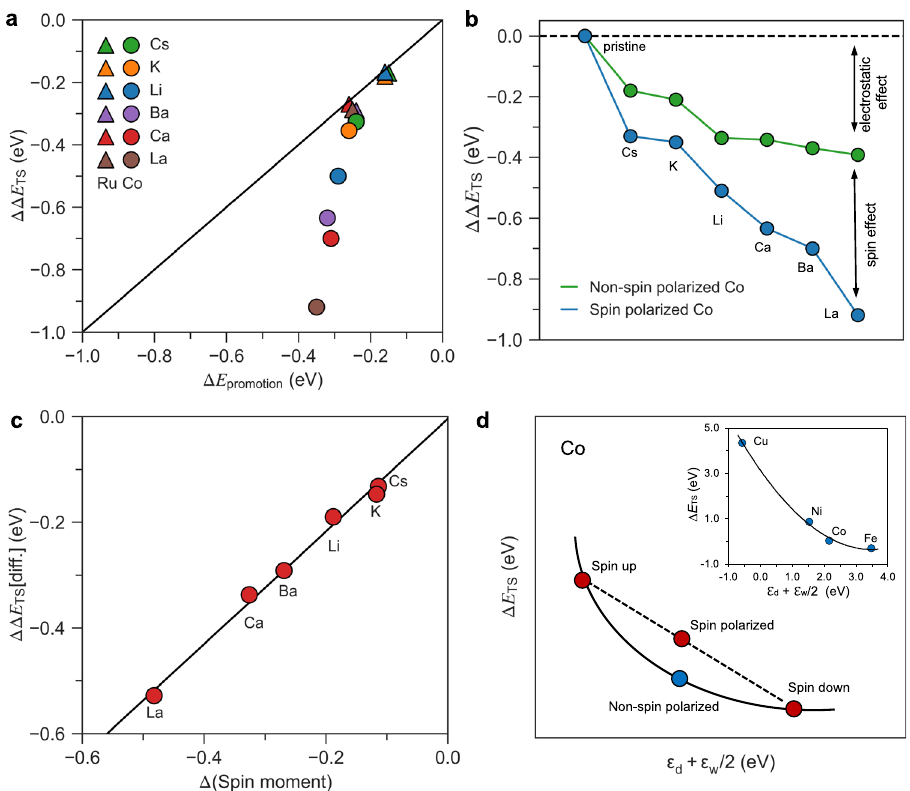
Fig. 3 Electrostatic and magnetic effects. a The N-N transition state (TS) energy stabilization ( ΔΔ E TS = Δ E TS (with promoter) – Δ E TS (without promoter)) for different promoters as a function of the electrostatic promotion ( Δ E promotion = – μ N-N ℇ promoter ). Triangles and squares refer to the Ru and Co surface, respectively. b ΔΔ E TS for different promoters for spin-polarized and non-spin-polarized Co. c The difference ΔΔ E TS [diff] = ΔΔ E TS (spin polarized) – ΔΔ E TS (non-spin polarized) between the TS energy for spin-polarized (blue in b ) and non-spin-polarized (green in b ) Co plotted as a function of the promoter- induced change in spin moment of the Co atoms at the active site (Supplementary Table 9). d Schematic plot of the relation between Δ E TS and the top of the d band on a spin-polarized and non-spin-polarized surface Inset shows our calculated Δ E TS on different non-spin-polarized late 3d metals as a function of the top of the d band taken from Ref. 30 displaying a nonlinear dependence for the late 3d